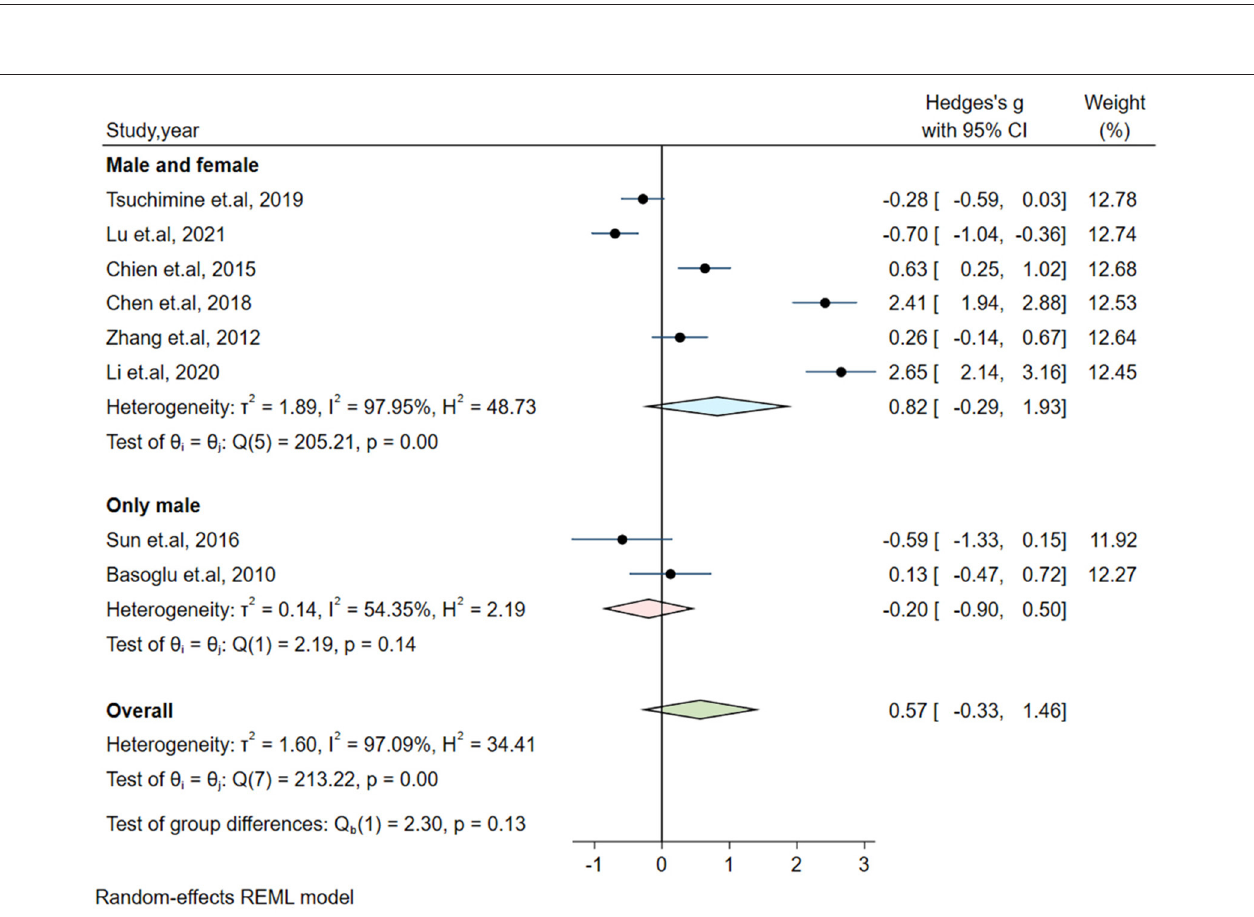
FIGURE 3 | Subgroup analysis of plasma orexin-A levels in patients with schizophrenia compared to healthy controls (based on gender).